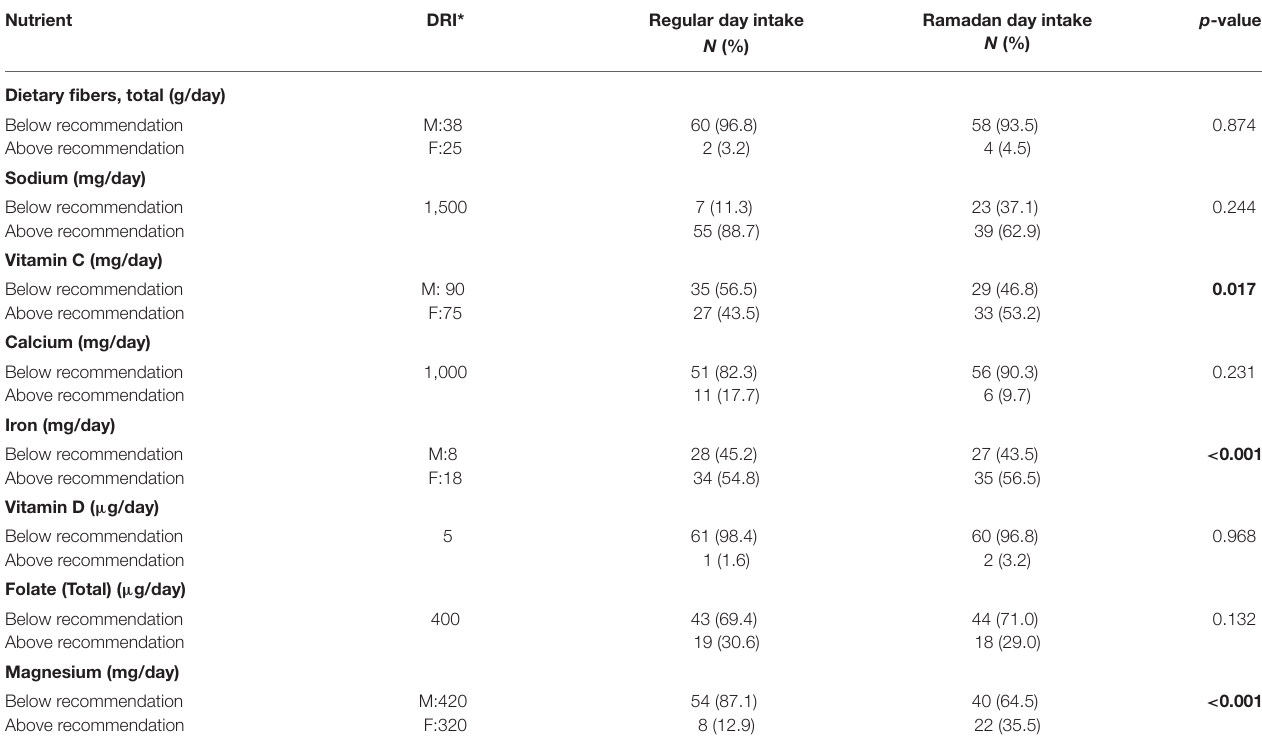
TABLE 4 | Dietary adequacy during regular days vs. the month of Ramadan among study participants ( n = 62). Nutrient DRI* Regular day